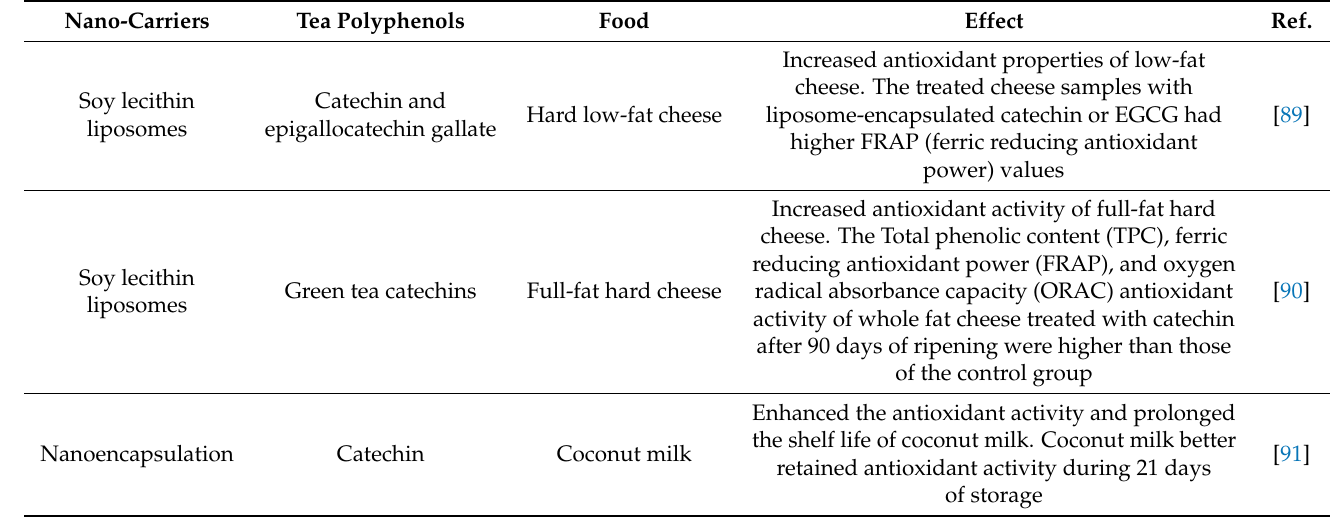
Table 2. Applications of TPs nanostrategies in food quality